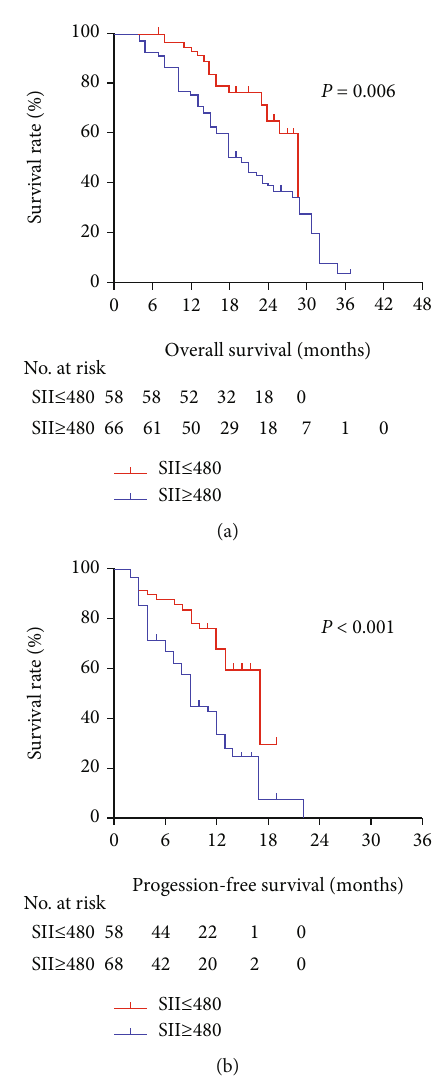
Figure 4: (a) Overall survival and (b) progression-free survival graphic based on SII